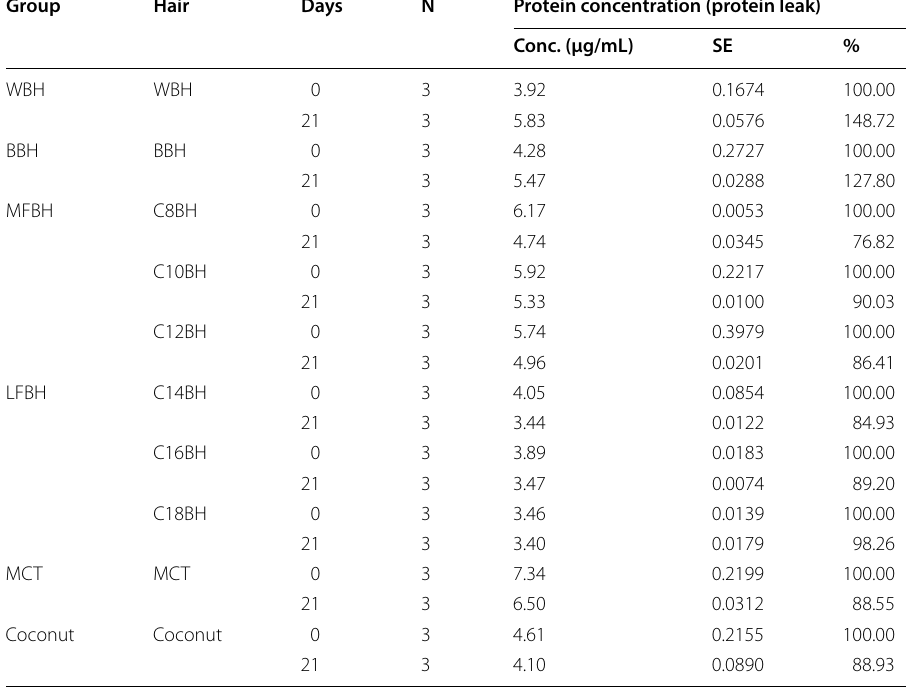
Table 8 Concentration of protein extracted from bleached hair (BH) before and after 21 days of applying different hair treatments Group